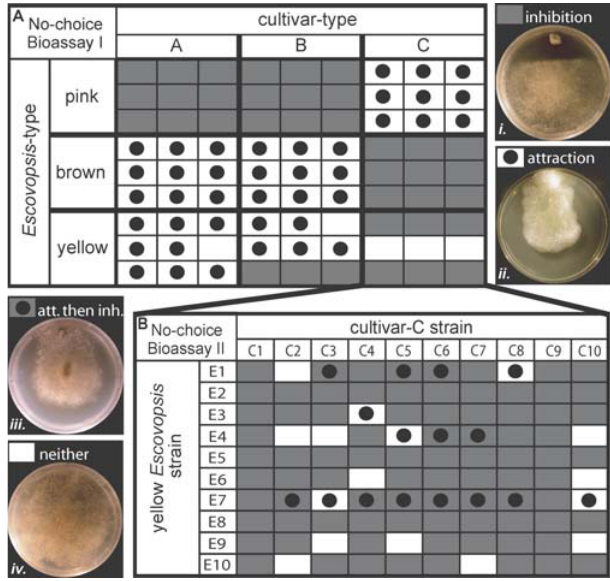
Figure 3. No-Choice Bioassays Each cell represents the outcome of the interaction between one cultivar and one Escovopsis isolate. Gray indicates inhibition (i), a dot indicates attraction and subsequent infection (ii), gray with a dot indicates attraction followed by inhibition (iii, note that the cultivar is not overgrown), and white indicates neither attraction nor inhibition (iv). (A) No-choice bioassay I. Interaction between three isolates of cultivars A, B, and C and three isolates of each of the Escovopsis morphotypes. (B) No-choice bioassay II. Interaction of ten yellow Escovopsis isolates confronted with ten cultivar-C isolates. These 100 bioassays are a more exhaustive dataset corresponding to the nine yellow Escovopsis –cultivar C trials in no-choice bioassay I. DOI: